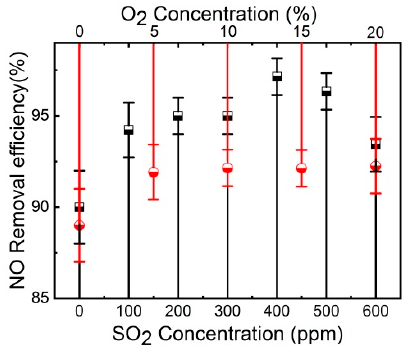
Figure 10. Effects of O 2 and SO 2 on NO removal efficiency. Reaction conditions: NaClO 2 concentration 0.01 mol/L; initial pH 3; temperature 30 °C; NO inlet concentration 500 ppm; N 2 balance, with a total flow rate of 1.5 L/min.